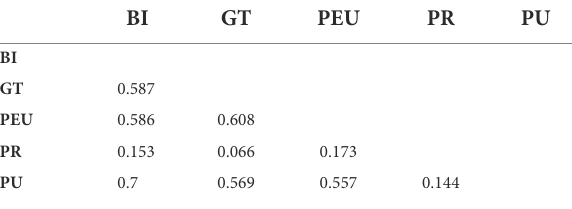
TABLE 5 Heterotrait–Monotrait ratio (HTMT) criterion.